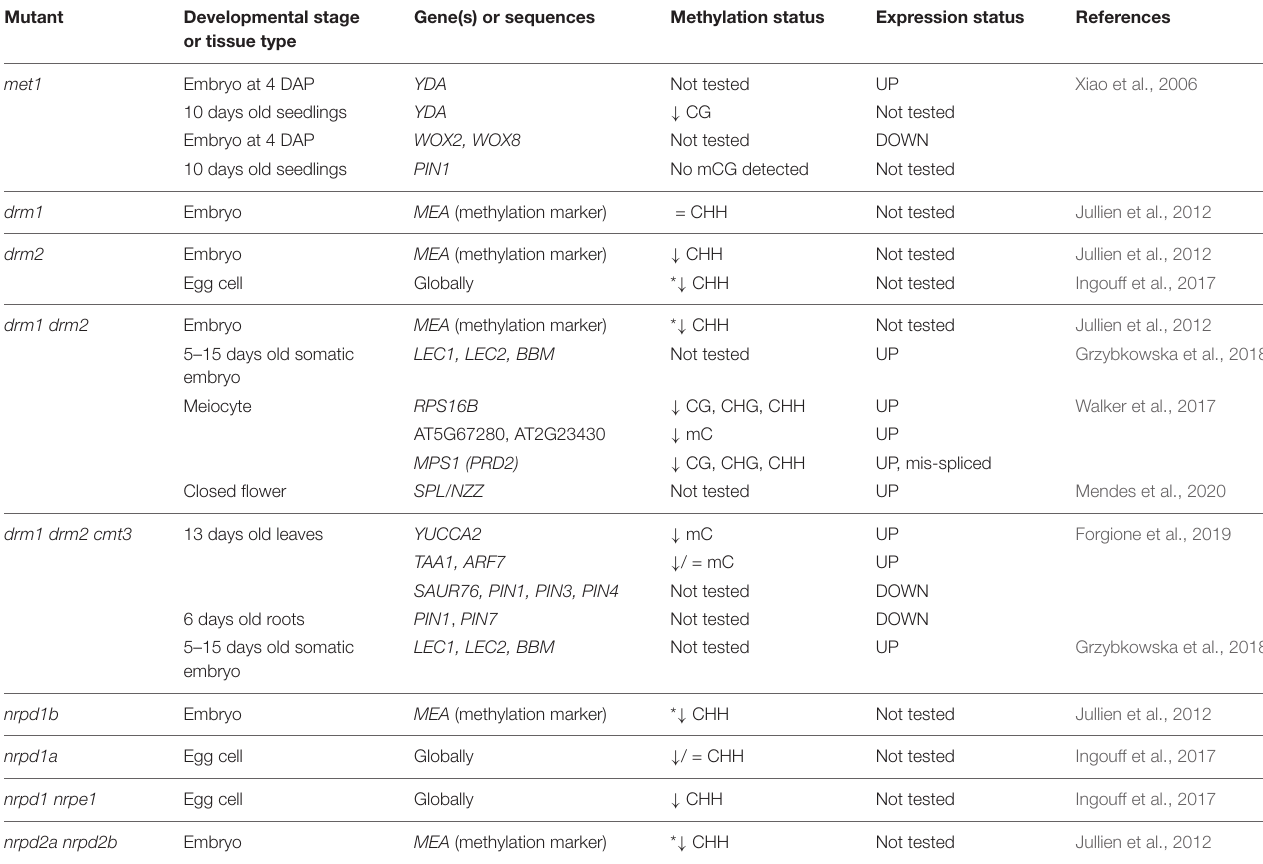
TABLE 1 | Changes in DNA methylation and/or gene expression detected in embryos and young seedlings of Arabidopsis mutants with non-functional DNA methylation mechanisms.